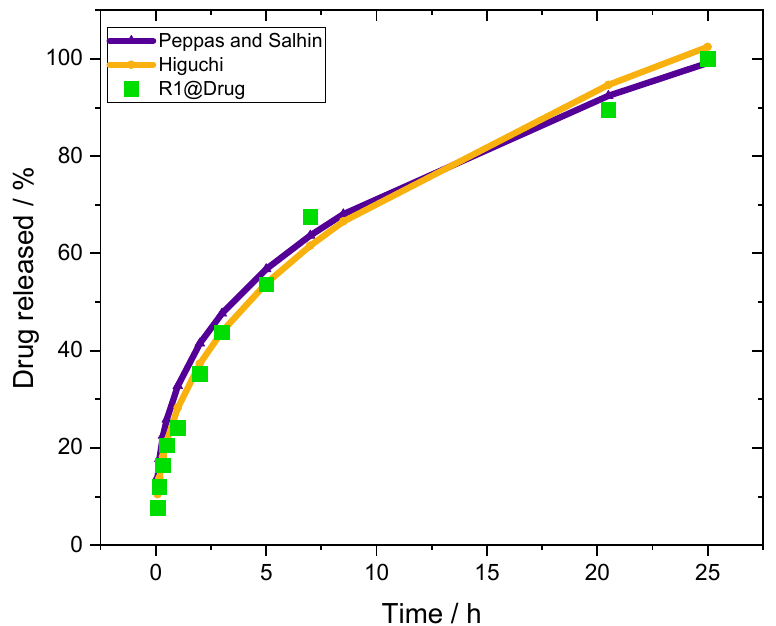
Figure 8. Kinetic release of the maslinic acid encapsulated into PLGA@Ag 2 S@SPION_R3 NPs (green dots). Higuchi model (orange line) and Peppas and Salhin model (blue line).